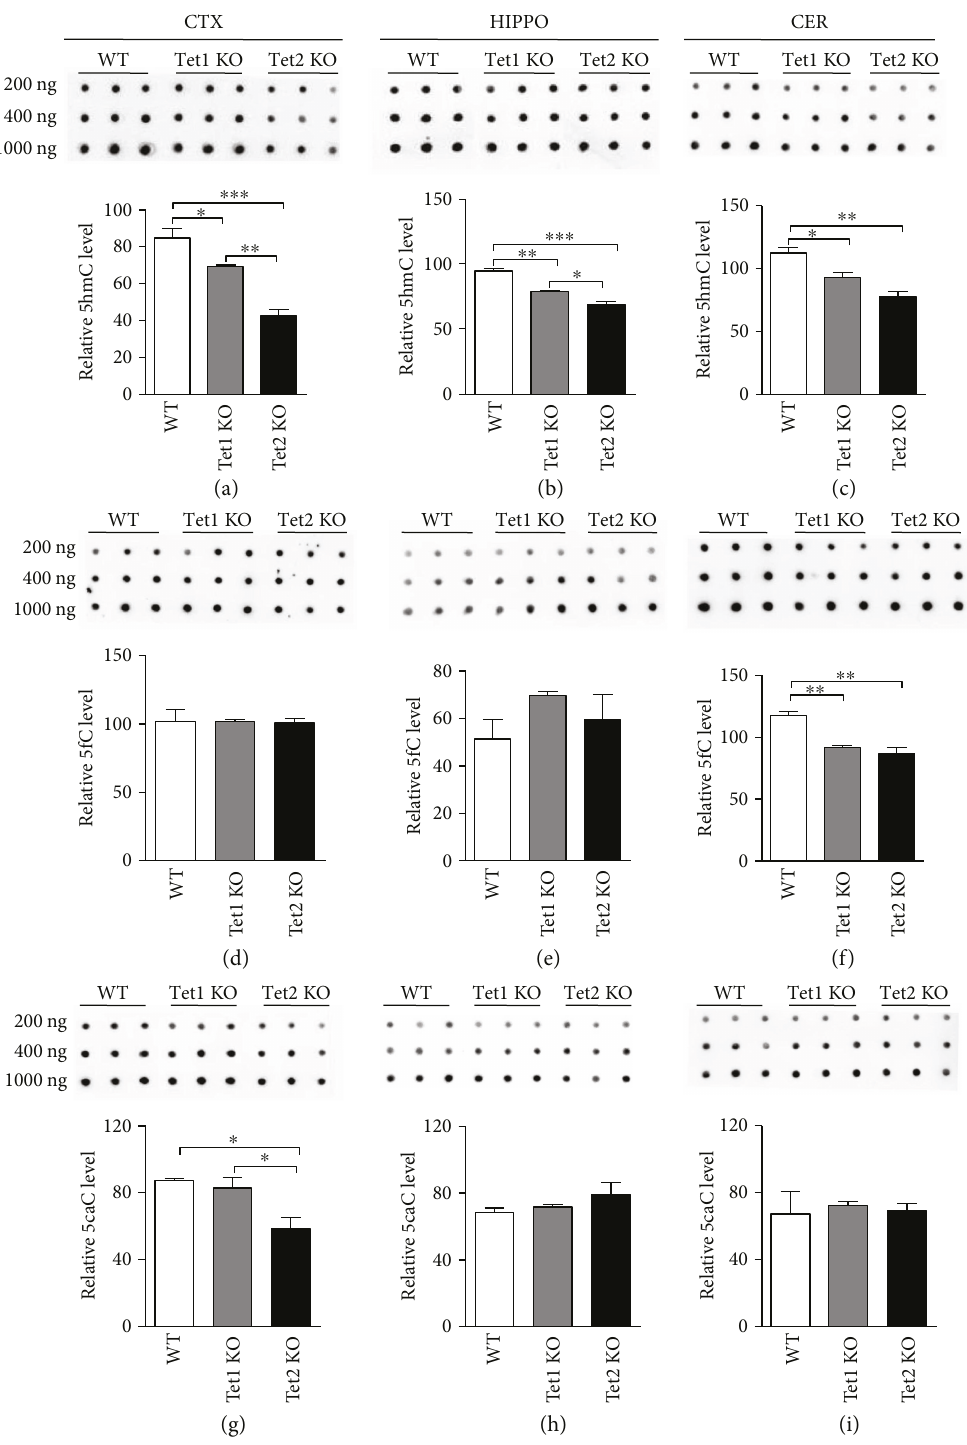
Figure 4: 5hmC, 5fC, and 5caC in Tet1 and Tet2 knockout brain using DNA dot blot. The levels of 5hmC, 5fC, and 5caC in the cortex ((a), (d), (g)), hippocampus ((b), (e), (h)), and cerebellum ((c), (f), (i)) of adult Tet1 and Tet2 KO mice. Data are represented as mean ± SEM ( n = 3 ). Statistically signi fi cant di ff erences are indicated: ∗ p < 0 05 , ∗∗ p < 0 01 , and ∗∗∗ p < 0 001